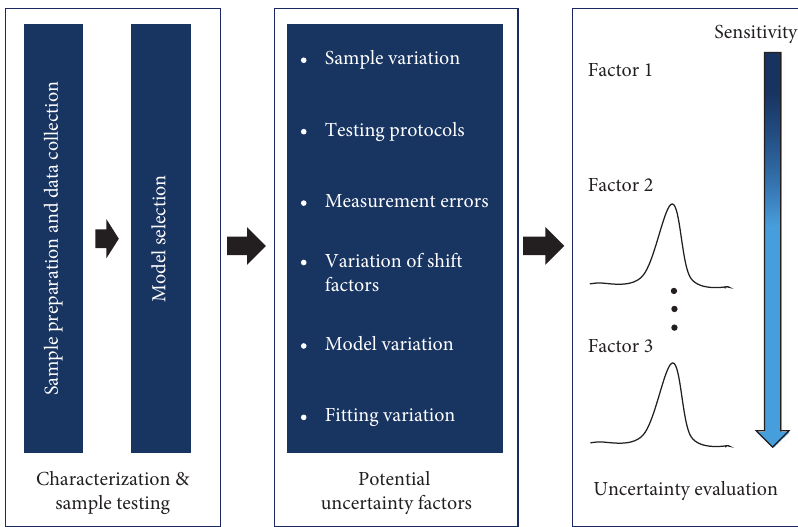
Figure 1: Qualitative analysis of uncertainty factors in master-curve